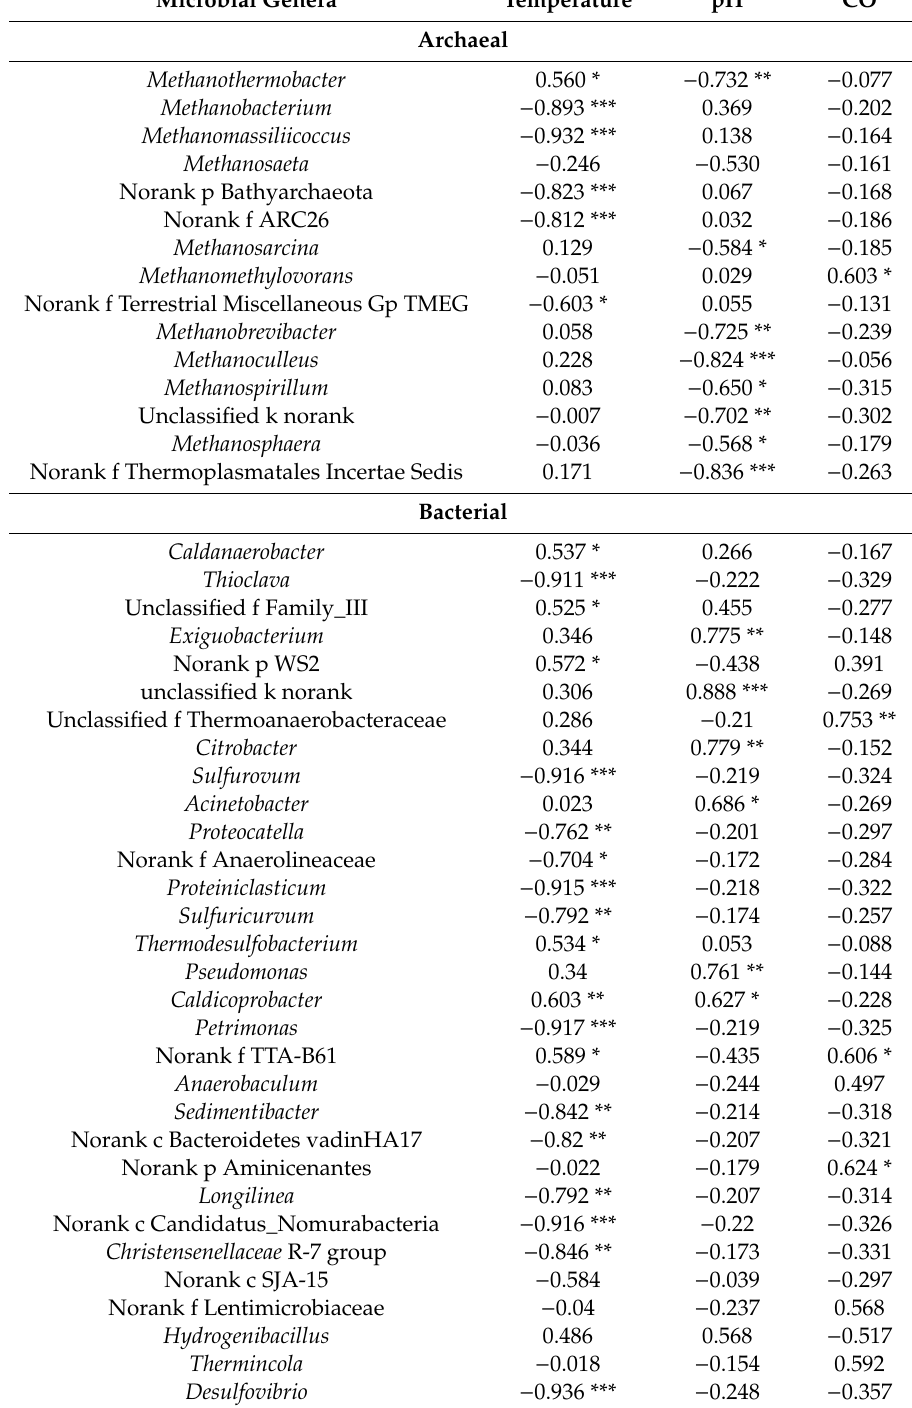
Table 3. Correlation coe ffi cients between abundant microbial genera and environmental variables. Microbial